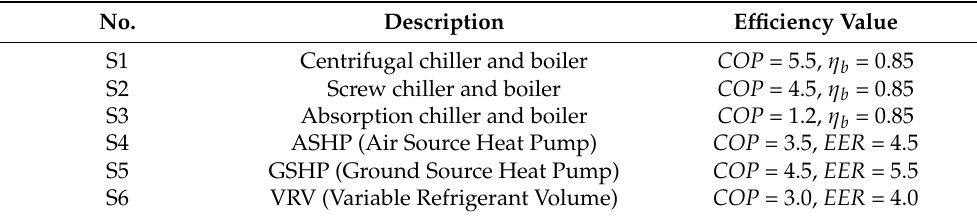
Table A2. Efficiency values of cooling/heating sources in the models.